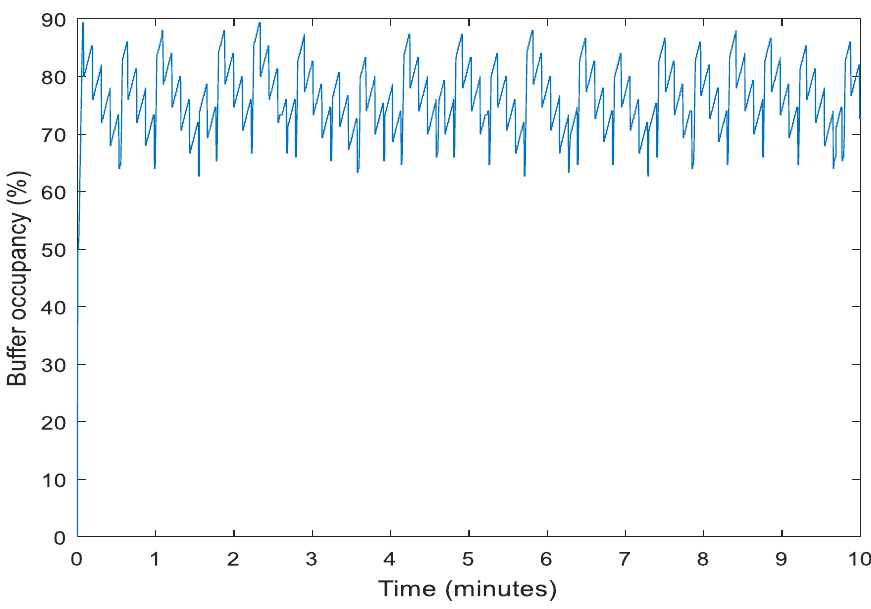
Figure 11. Buffer occupancy with DCCP at 0.5 Mbps.